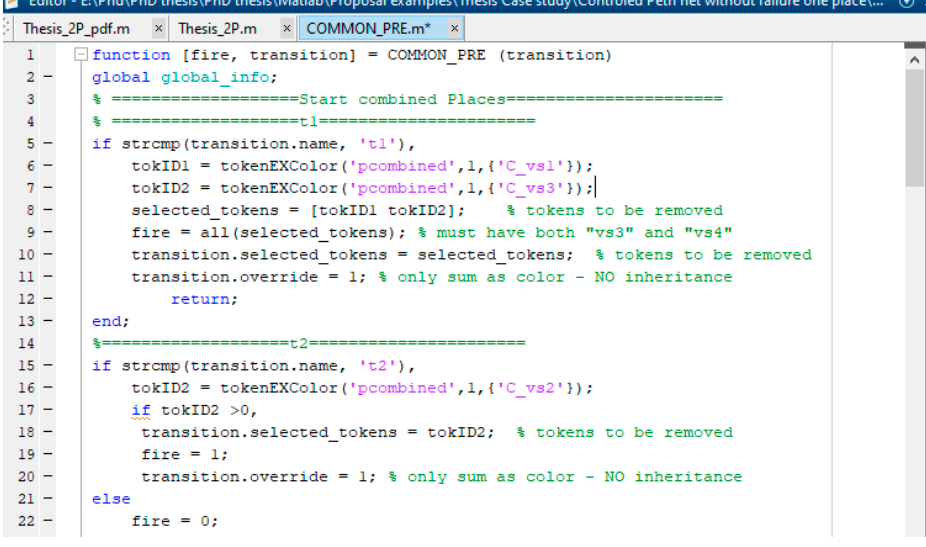
Figure 10. Part of the COMMON_PRE file of the colored controlled S 3 PR Petri net model from Figure 7.